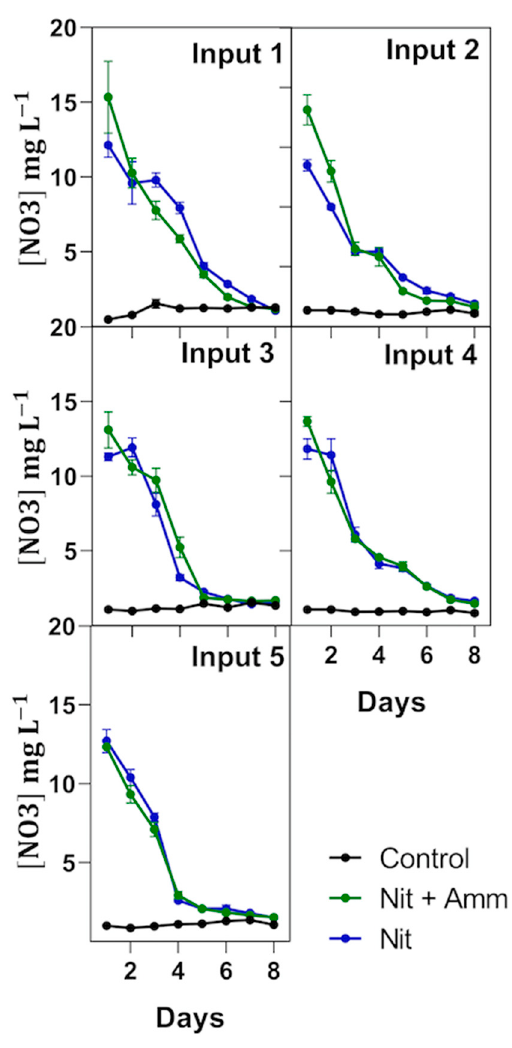
Figure 4. Nitrogen removal by treatment and input. Nitrate-nitrogen (NO 3 − N) concentration in each treatment is expressed in mg L − 1 and measured during an 8 day period from nutrient input over 74 days of experimentation. Treatments were irrigated with nitrate-N and ammonium-N (Nit + Amm), nitrate-N (Nit), or with sea water only (Control group). Each input corresponds to a new irrigation with nitrate-N and ammonium-N (Nit + Amm) or nitrate-N (Nit). Mean values of three lysimeters per treatment are displayed (±SE).